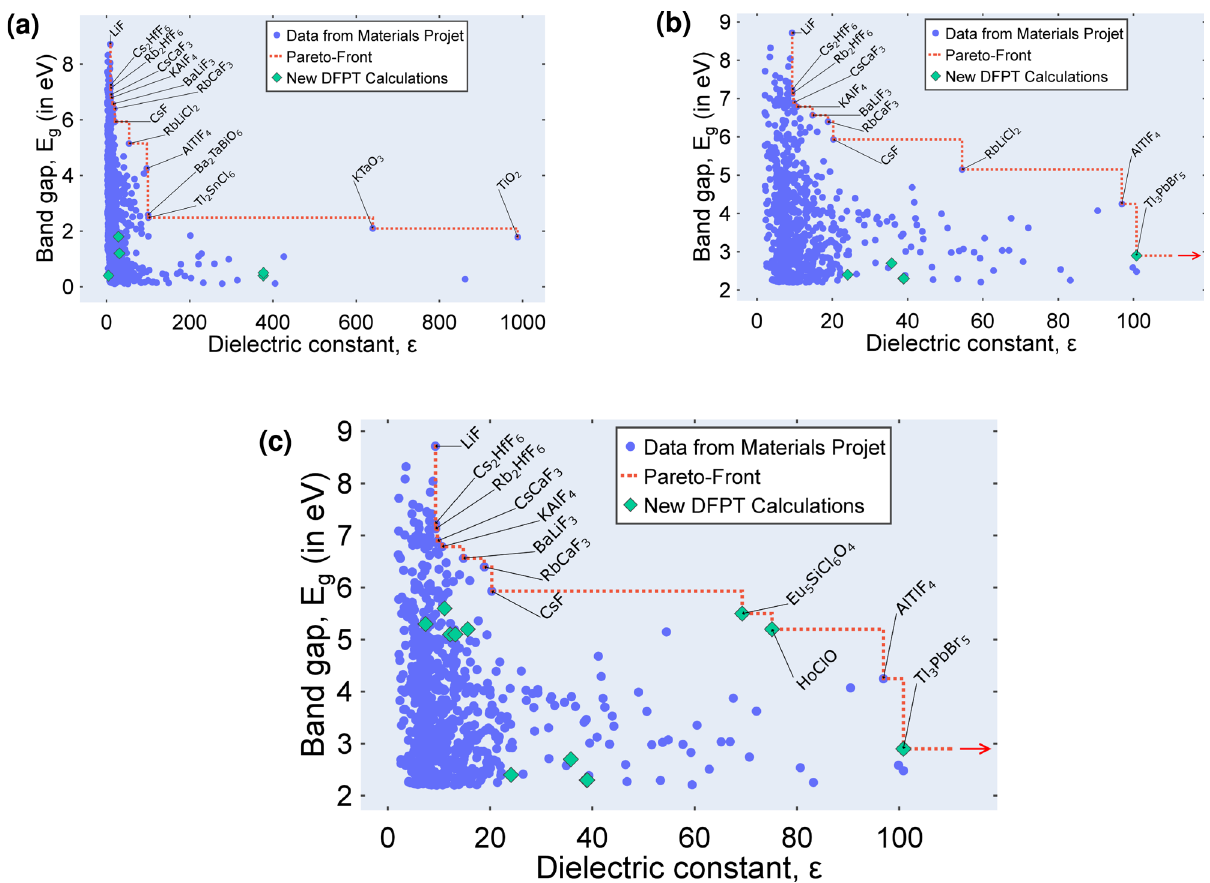
Fig. 5 Evolution of the Pareto front with design cycles. The ϵ and E g values of the training-data and newly characterized dielectric materials are plotted for a design cycle 1, b design cycle 2, and c design cycle 3. All the data shown in these plots originated from DFPT calculations. Plot a shows the original Pareto front of the dataset from Materials Project (MP) because none of the materials measured in cycle 1 became part of the Pareto front — predominantly owing to their low band gap values. Assigning no restrictions on the band gap of search-space materials during the fi rst cycle directed the design algorithm to pick two materials without any preference for large band gaps. The numerical values of the materials in the Pareto front of the MP dataset are given in Table 1. In both b and c , only the materials with E g values greater than 2.0 eV are plotted to highlight the area where some of the newly discovered dielectrics in their corresponding cycles joined the Pareto front. Due to this cropping, two materials from the MP dataset which are actually in the Pareto front in plots b and c with very high ϵ values — tetragonal TiO 2 ( ϵ = 988, E g = 1.8 eV) and cubic KTaO 3 ( ϵ = 640, E g = 2.1 eV), are not shown